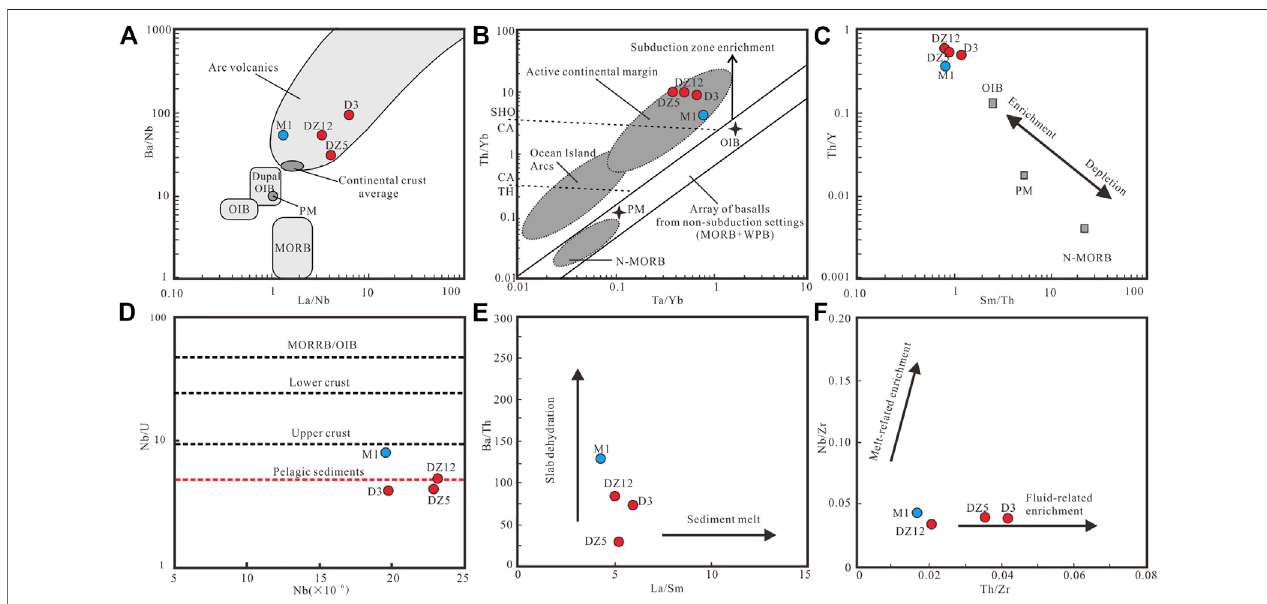
FIGURE 8 | Plot of (A) Ba/Nb vs. La/Nb (after Niu et al., 2017). (B) Th/Yb vs. Ta/Yb (after Pearce, 1983). (C) Th/Y vs. Sm/Th (after Su et al., 2012), the reference fi elds for primitive mantle (PM), OIB, and N-MORB are from Sun and McDonough (1989). (D) Nb/U vs. Nb diagram for the lamprophyres in the Tuquan Basin. Data sources: MORB and OIB (Hofmann et al., 1986), lower and upper crust (Taylor and McLennan, 1985), pelagic sediments (Plank and Langmuir, 1998). (E) Ba/Th vs. La/ Sm (after Labanieh et al., 2012). (F) Nb/Zr vs. Th/Zr (after Kepezhinskas et al., 1997). Abbreviations are as follows: WPB, within-plate basalts; N-MORB, normal mid-ocean ridge basalts; OIB, ocean island basalts; MORB, mid-ocean ridge basalts; PM, primitive mantle; TH, tholeiitic; CA, calc-alkaline; SHO, shoshonitic.